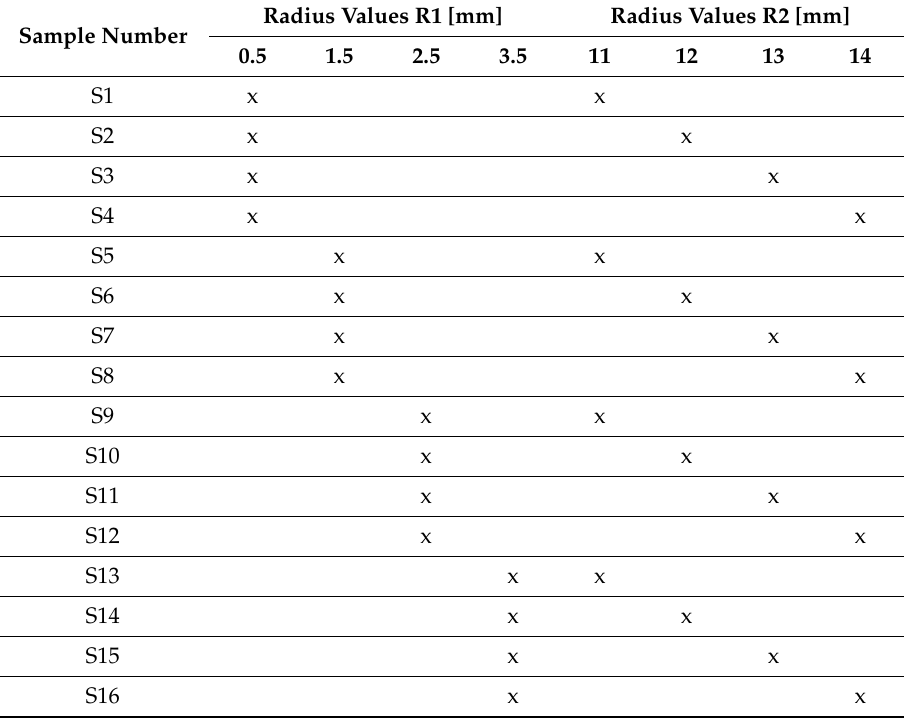
Table 6. Programming experiments through the method of factorial